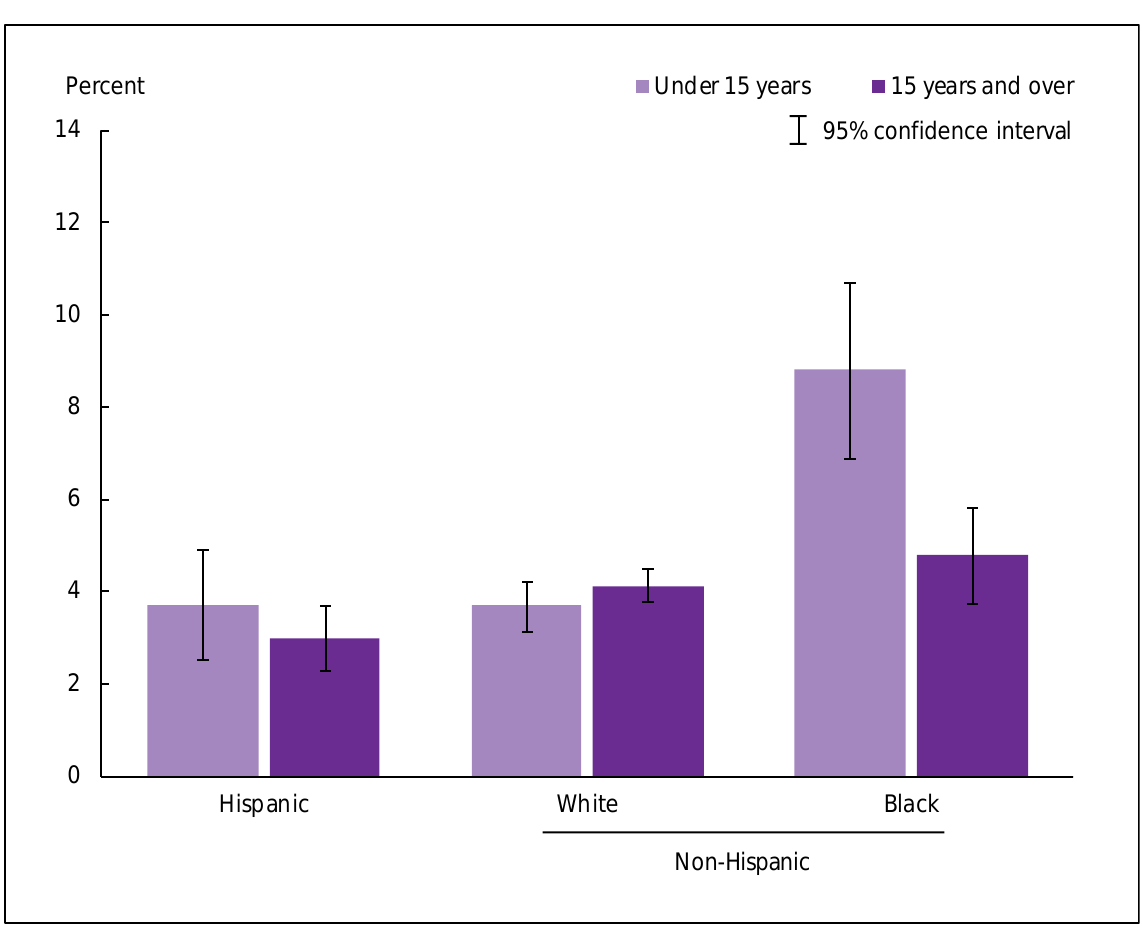
Figure 15.3. Sex-adjusted percentage of persons of all ages who experienced an asthma episode in the past 12 months, by age group and race and ethnicity: United States,